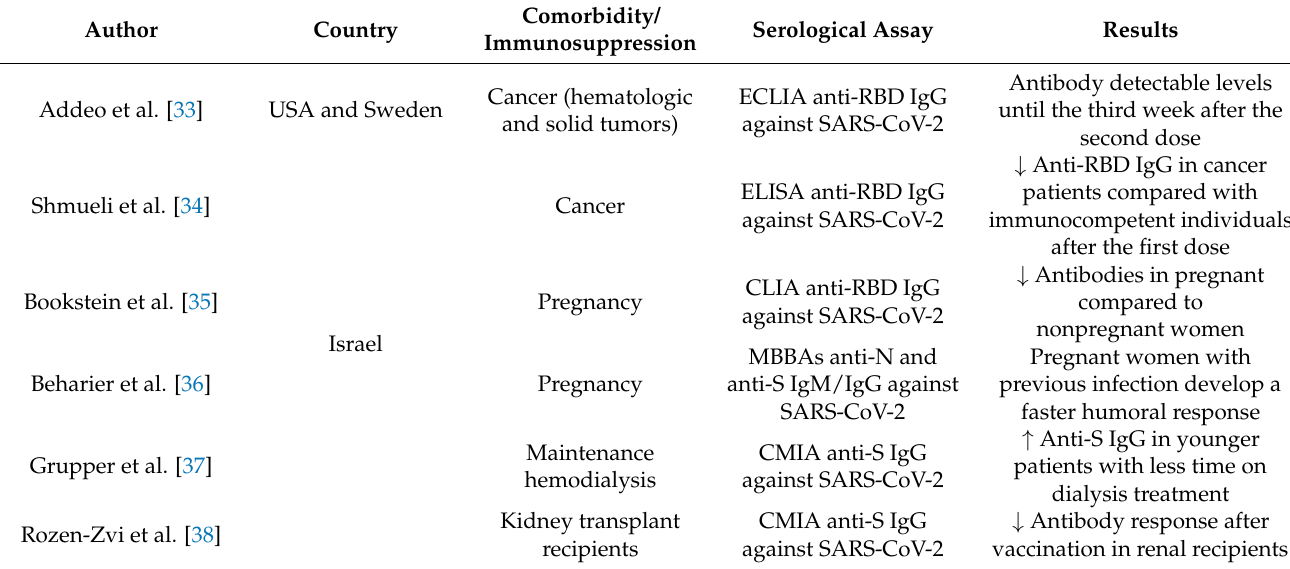
Table 3. Effect of comorbidity and immunosuppression in the antibody response induced by the administration of BNT162b2 vaccine.